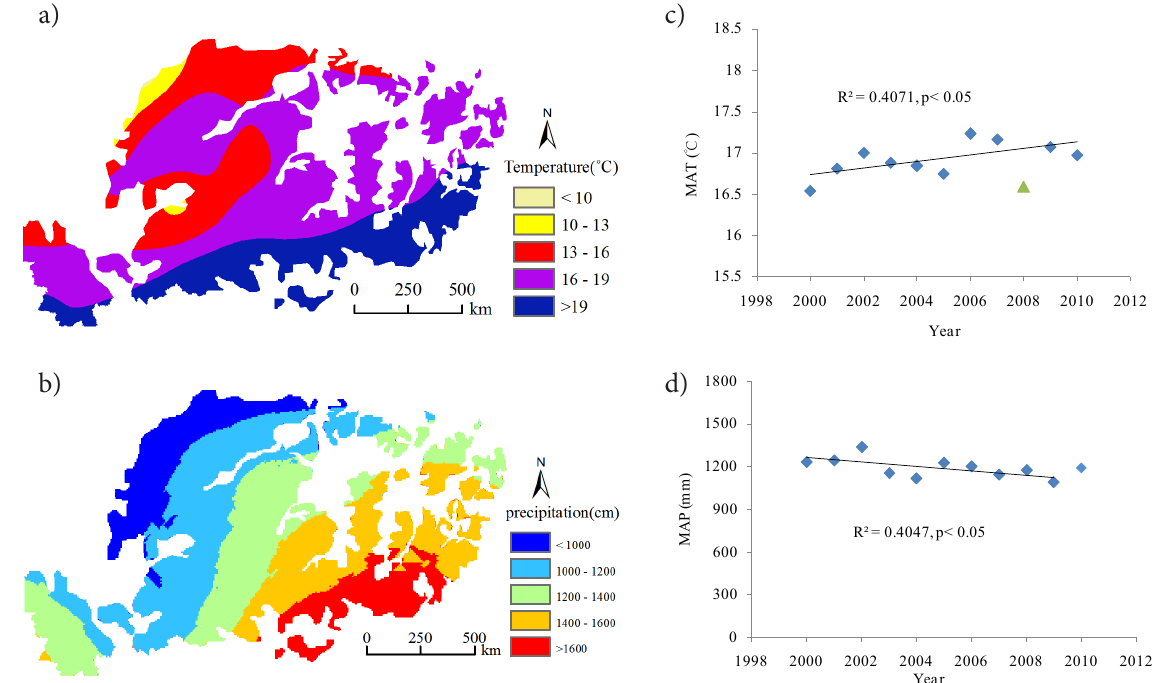
Figure 3. Spatial patterns and temporal changes of climate variables in the study region. (a) temperature surface; (b) precipitation surface; (c) mean annual temperature (MAT); (d) mean annual precipitation (MAP). Mean annual temperature shows significantly increasing trend except a relatively low value in 2008, while mean annual precipitation shows significantly decreasing trend during the study